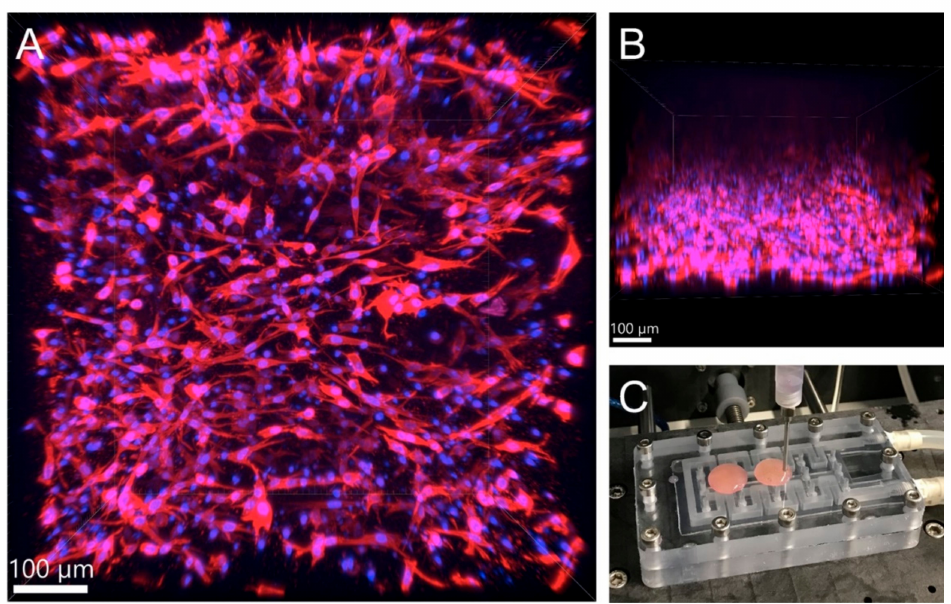
Figure 5. Porcine stromal cells in 3D printed collagen hydrogel (15 mg/mL), substrate coverslip glass, red F-actin, blue cell nuclei. ( A ) 3D image from confocal microscopy. ( B ) side projection from confocal microscopy. ( C ) printing process on substrate fixed using heated vacuum bed. The microscopy image was acquired on Andor Dragonfly spinning disk confocal system with high-speed CMOS camera Zyla 4.2 (Andor Technology Ltd., Belfast, UK) mounted on Leica DMi8 inversed fully mechanized microscope (Leica, Wetzlar, Germany) using 20 × lens (NA = 0.75) with water immersion. The wavelengths of the excitation lasers were 405 nm and 561 nm and the transmission characteristics of the emission filters were 450/50 nm and 600/50 nm. Used disk pinhole diameter was 40 µ m. The hydrogel samples were photographed in PBS buffer in 35 mm Petri dish with #1.5 glass bottom (0.17 mm thickness, Cellvis, Sunnyvale, CA,